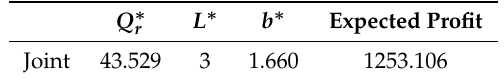
Table 4. Optimal solutions for the consignment